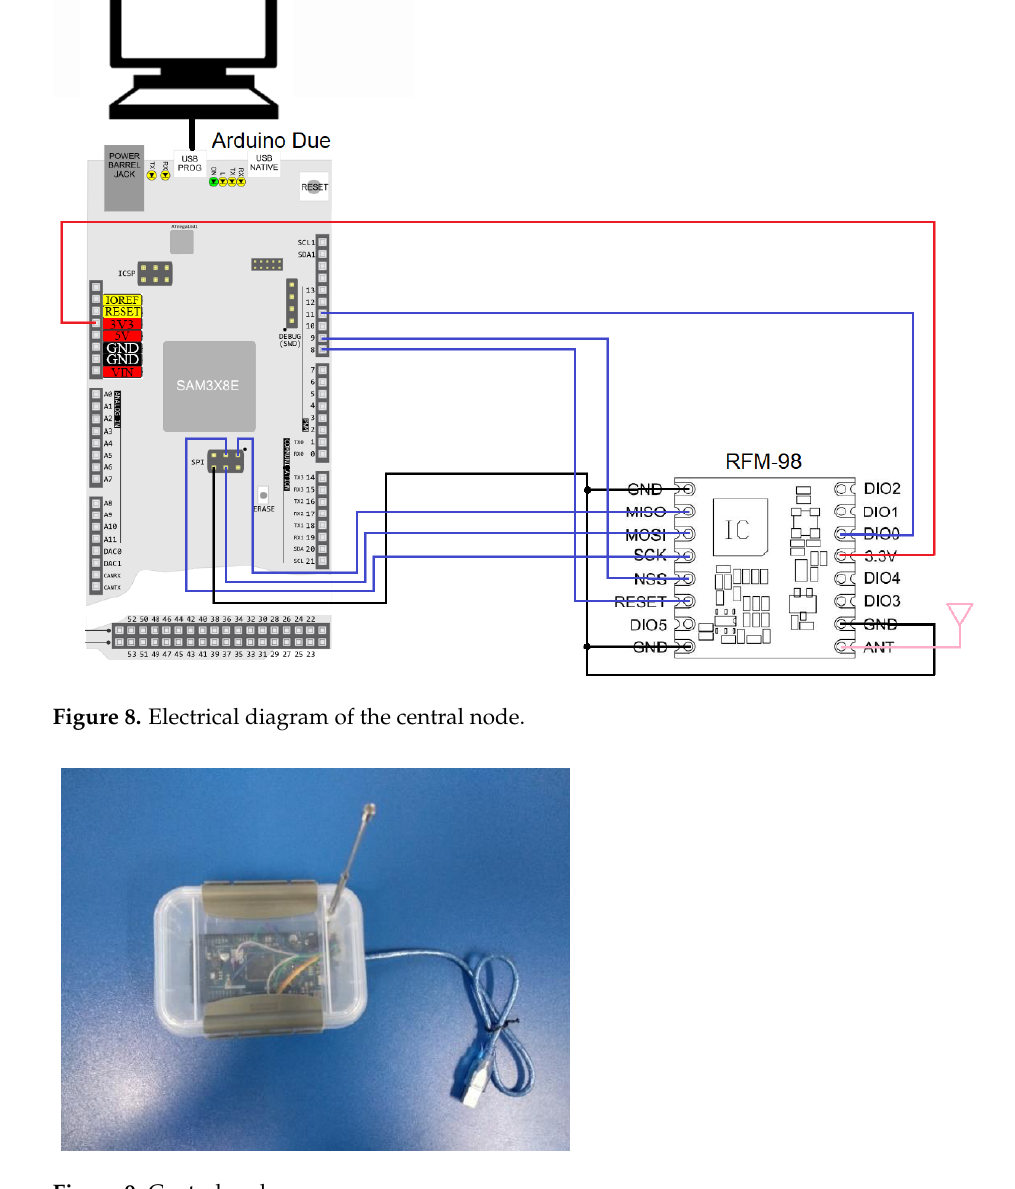
Figure 9. Central node.